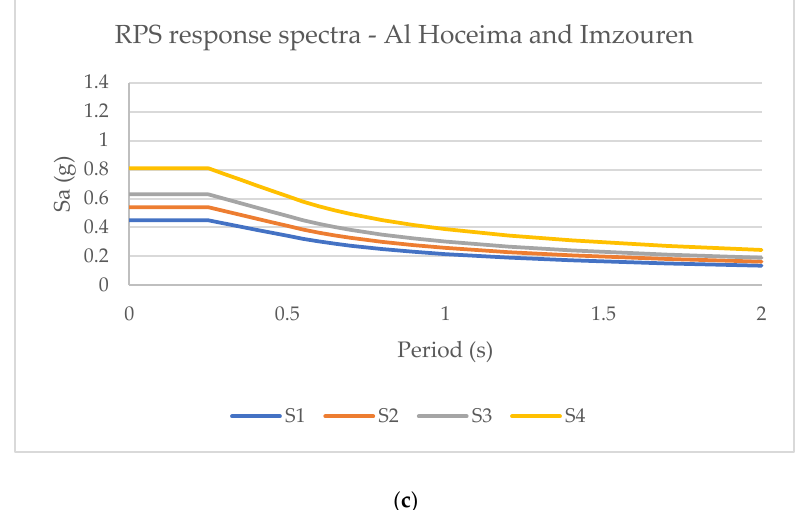
Figure 6. Response spectra of the cities of Al Hoceima and Imzouren for each soil type: ( a ) Eurocode 8 response spectra Al Hoceima; ( b ) Eurocode 8 response spectra Imzouren; ( c ) RPS response spectra Al Hoceima and Imzouren.